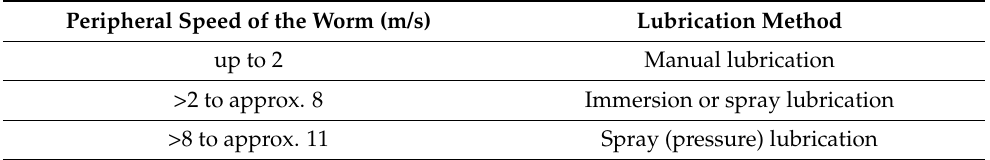
Table 1. Spiroid gear lubrication methods [28].